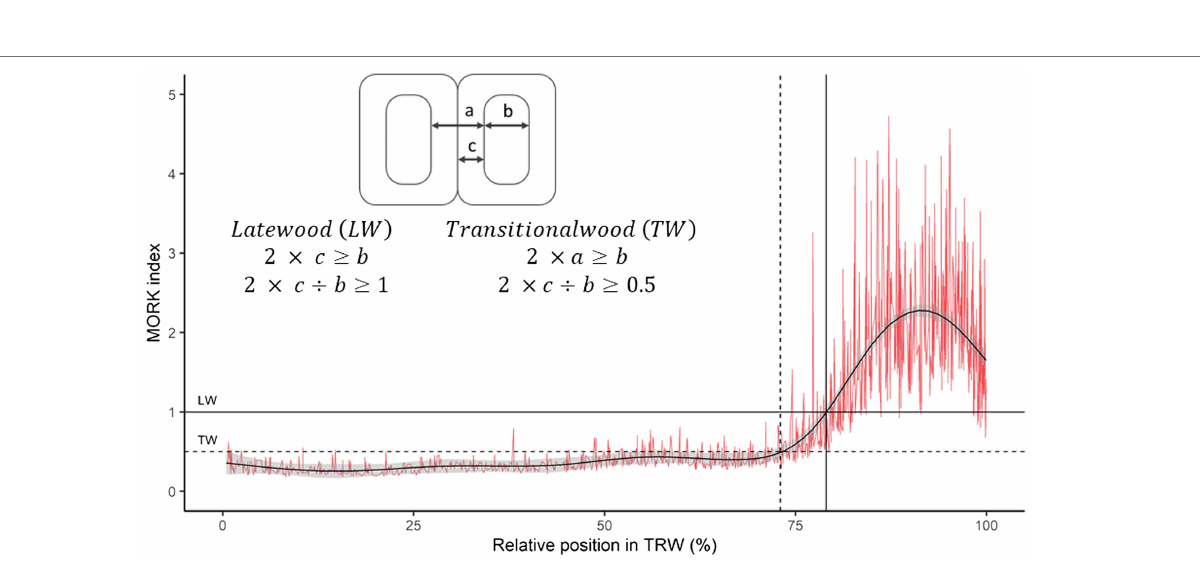
FIGURE 2 | Example of latewood and transitional wood determination within spruce tree ring. The red line shows the relationship between the double thickness of the radial tracheid wall and the radial diameter of the lumen, while the black curve represents a smoothing function